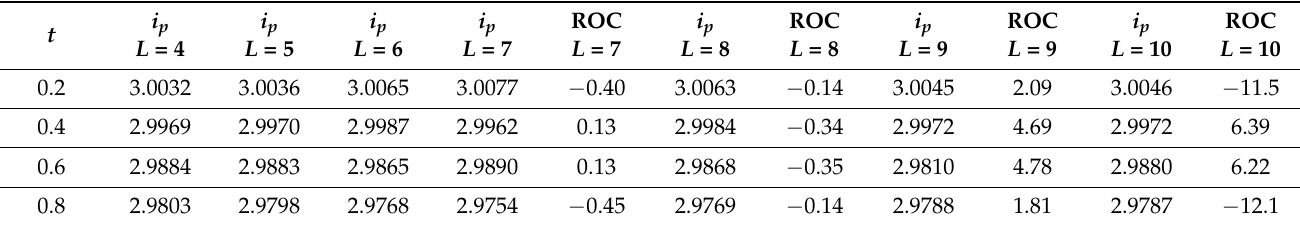
Table 10. The values of i p and rate of convergence (ROC) at different points for k = 0 and various values of L by sine– cosine wavelets.